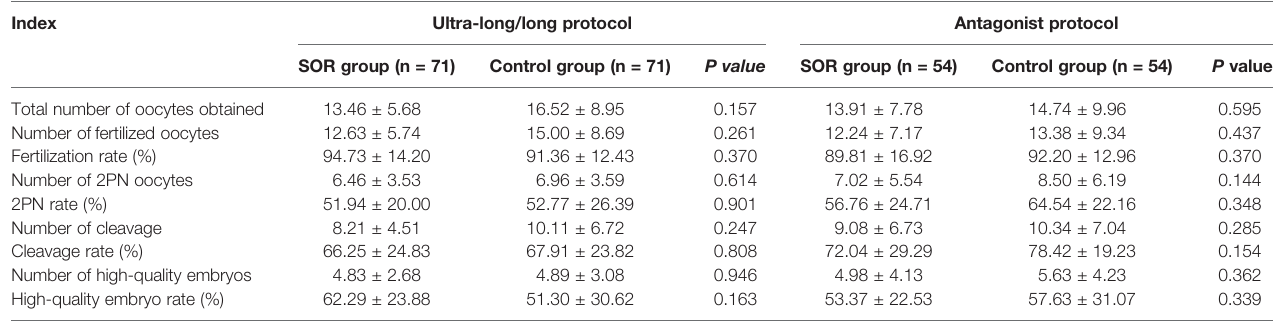
TABLE 4 | Comparison of the laboratory outcomes of IVF patients.